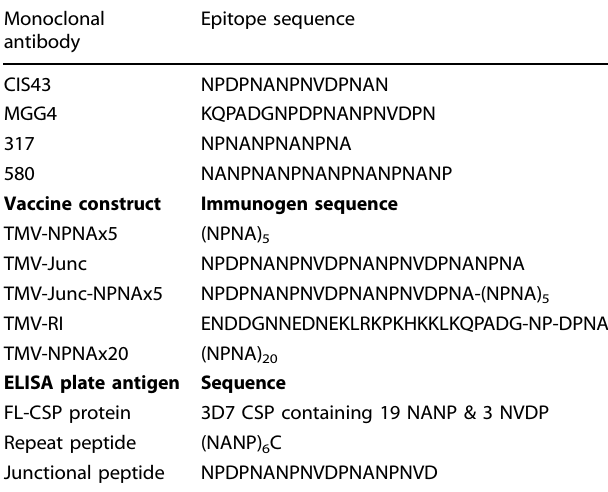
Table 1. Amino acid sequences of antibody epitopes, vaccine constructs, and ELISA plate antigens used in this study. Monoclonal